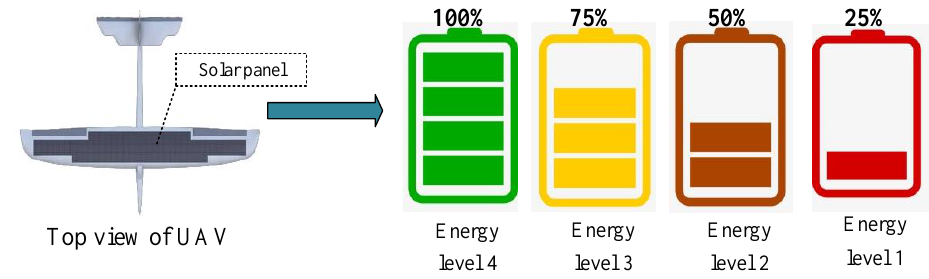
Figure 3. UAV energy level relationship.